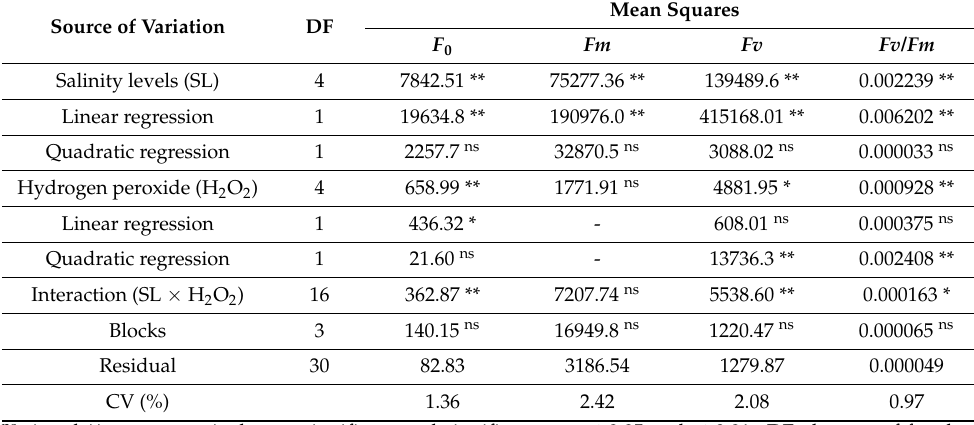
Table 2. Analysis of variance (F-test) summary of initial fluorescence ( F 0 ), maximum fluorescence ( Fm ), variable fluorescence ( Fv ), and quantum efficiency of photosystem II ( Fv/Fm ) of soursop plants cv. Morada Nova irrigated with saline water and subjected to foliar application of hydrogen peroxide at 210 days after transplantation.